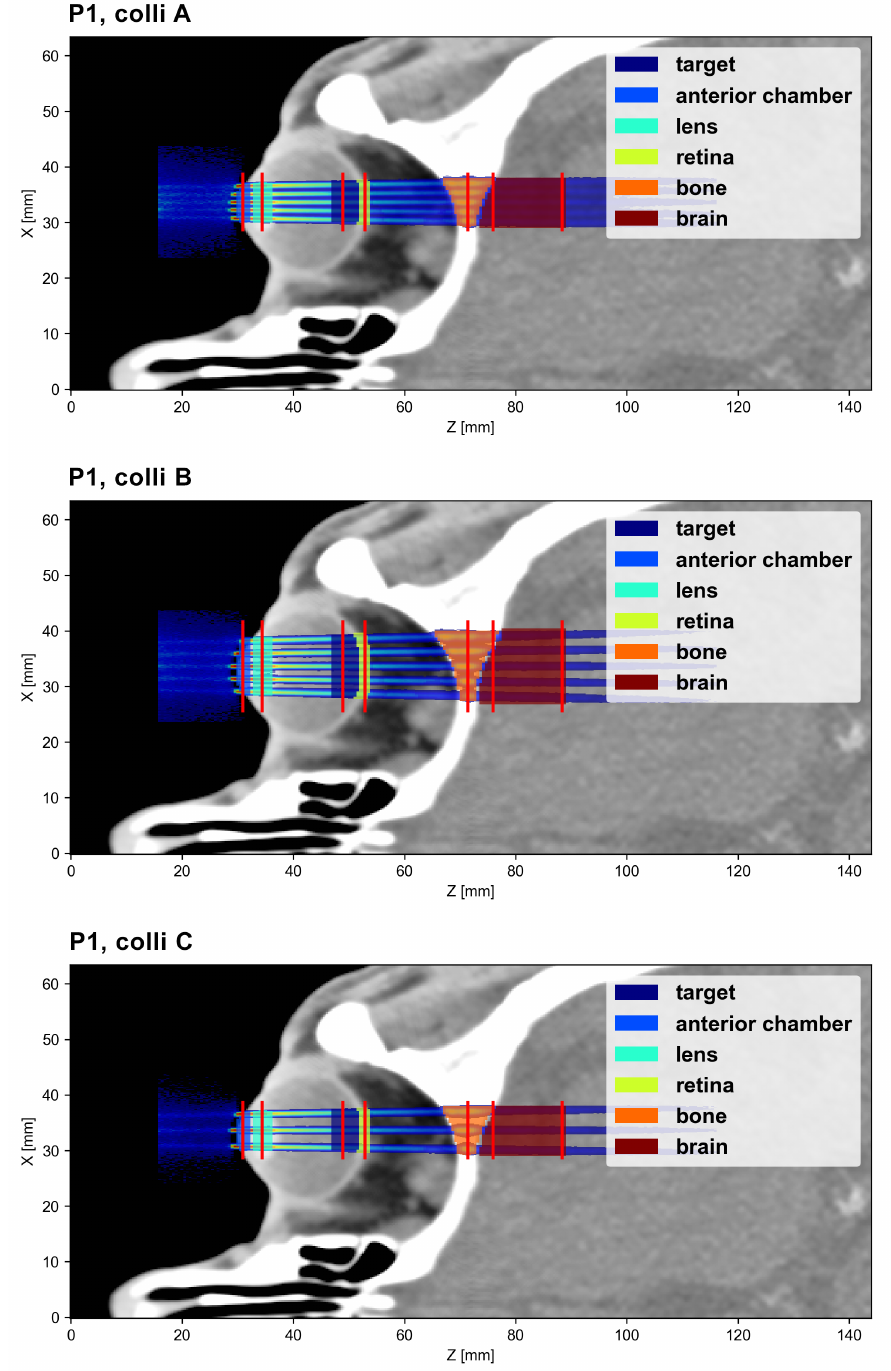
Figure 3. Dose analysis for the three P1 cases: The ROIs are shown and the sampling positions of the lateral profiles are indicated (red